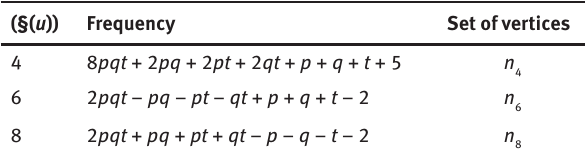
Table 1: Vertex partition of CeO vertex (§( u )) Frequency